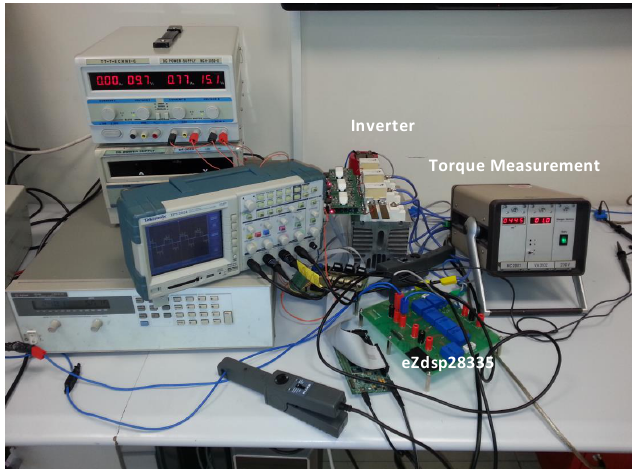
Figure 9. Experimental test-bed: prototype 24/20 slot–pole BLDC motor coupled to generator.